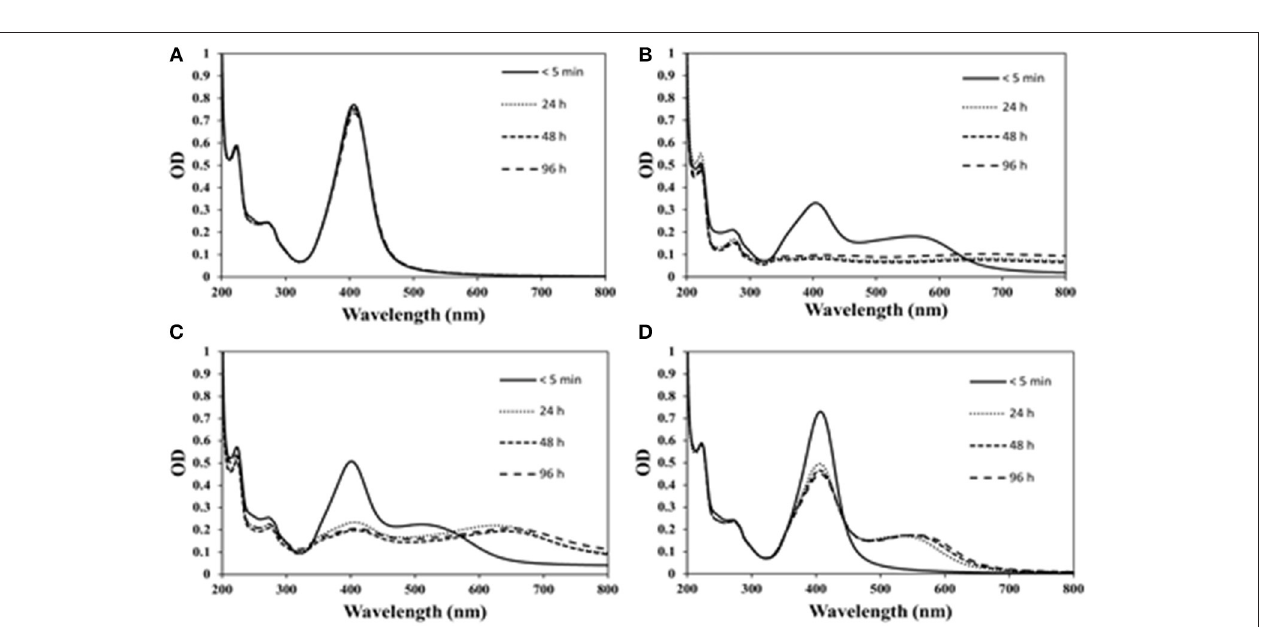
Frontiers in Environmental Science |